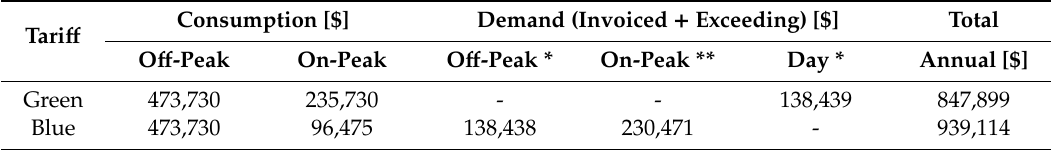
Table 5. Main results for Scenario 1.